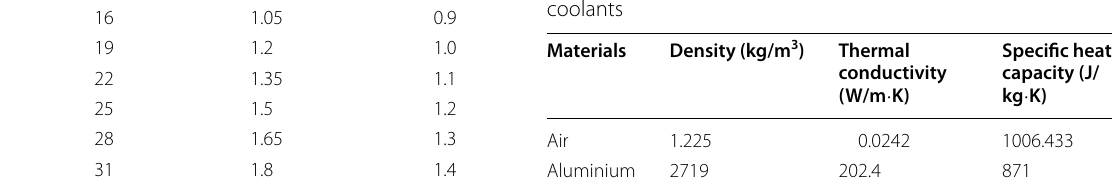
Table 2 Factors and levels of orthogonal tests